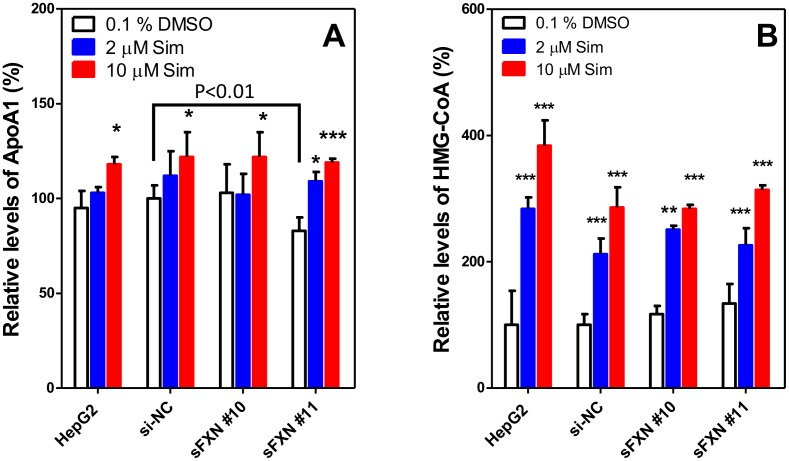
ApoA-I and HMG-CoA levels in HepG2 cells after treatment with simvastatin.(A) Relative levels of secreted ApoA1. (B) Relative HMG-CoA levels. Levels (means ± SD; n = 3) were normalized to cellular protein. P values are differences between simvastatin treated group and 0.1% DMSO treated group for each siRNA. *P < 0.05, **P < 0.01, ***P < 0.001. Cells were treated with simvastatin (SIM) was for 48 h.